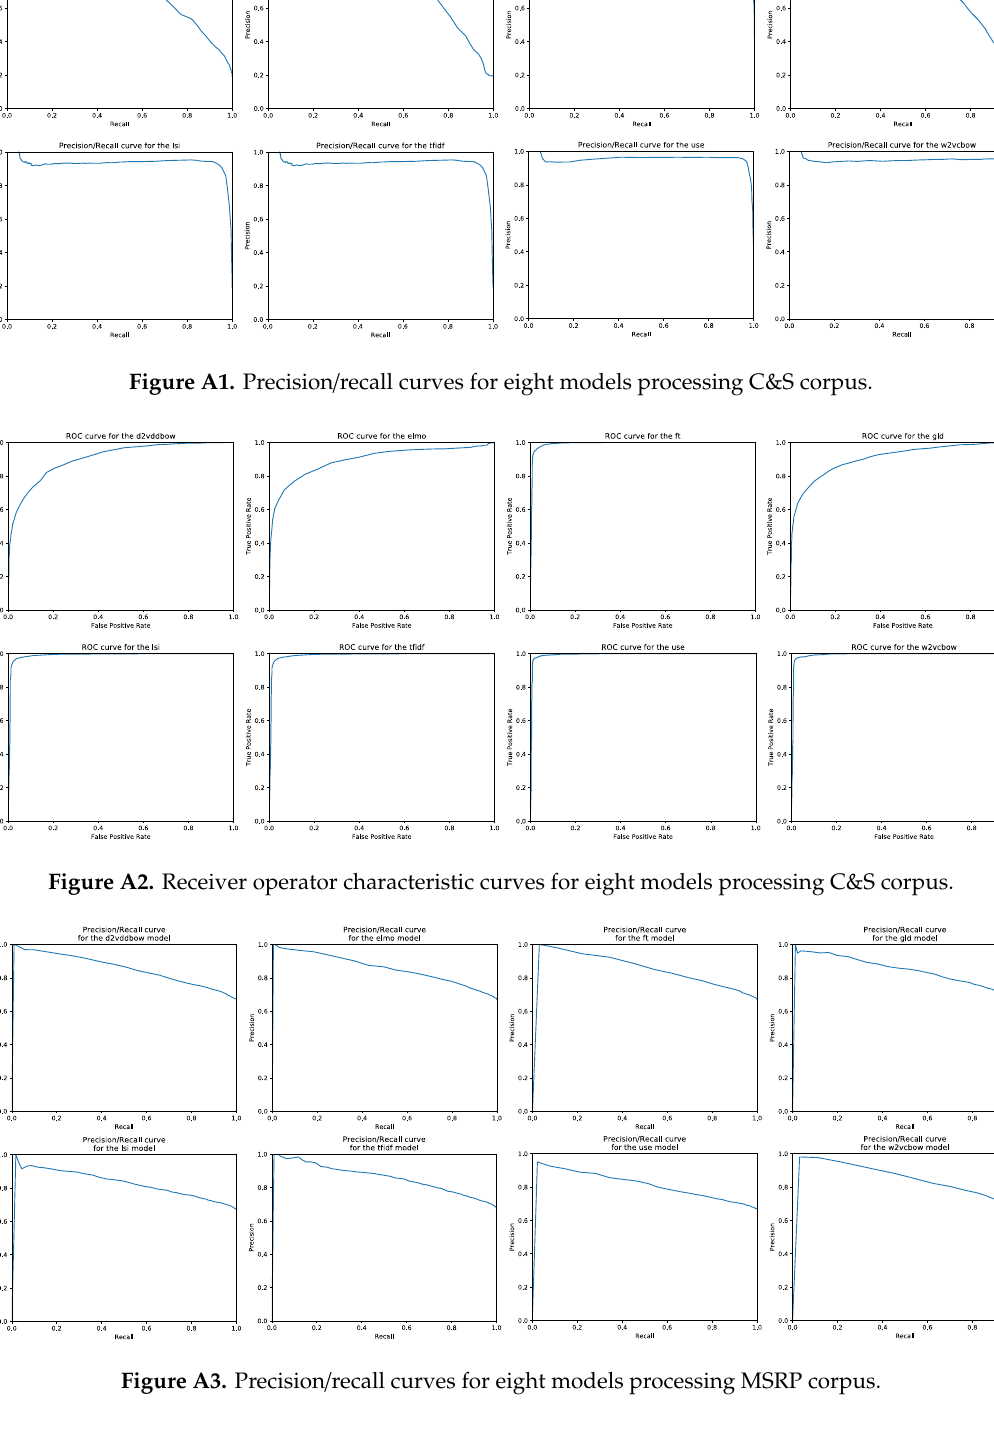
Figure A4. Receiver operator characteristic curves for eight models processing MSRP corpus.